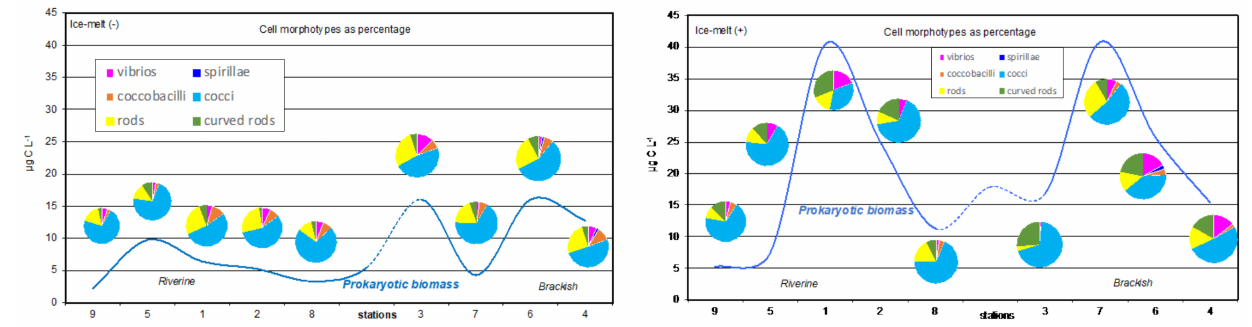
Figure 2. Distribution of prokaryotic biomass (line in blue) and abundance as a percentage of the total morphotypes at the riverine and brackish stations of the Pasvik River during the two seasonal samplings. May, Ice-melt ( − ); July, Ice-melt